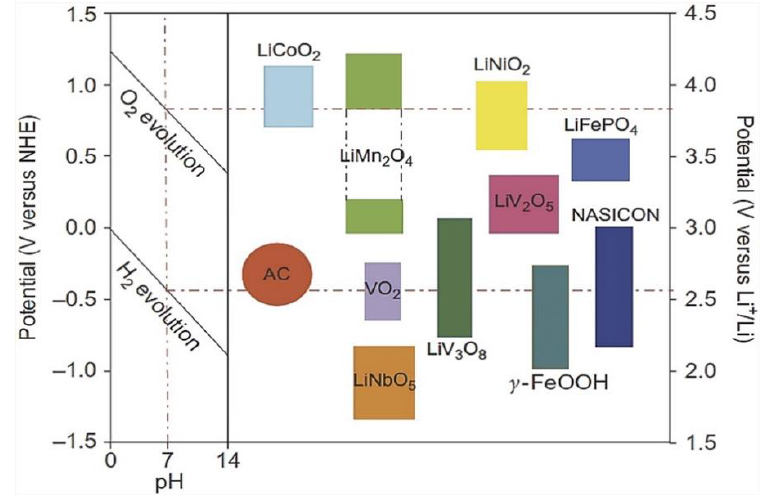
6 of 18 Figure 5. Schematic of lithium-extraction process. Reprinted with permission from Ref. [49]. Copy- right 2020 American Chemical Society. Although the above symmetric rocking-chair-battery-like system provides great flex- ibility in Li extraction from seawater, high ion-resistance caused by the anion exchange membrane leads to the high energy-consumption of the system, which needs to be further optimized. 3. Electrode Materials 3.1. Working Materials Electrochemical Li-extraction is achieved by using the principle of Li + transfer be- tween electrode and electrolyte, during the charging and discharging process of the Li- ion battery (LIBs) [9,51]. Theoretically, any cathode or anode material that can be used for rechargeable LIBs may be used to extract Li from brine/seawater. As shown in Figure 6,